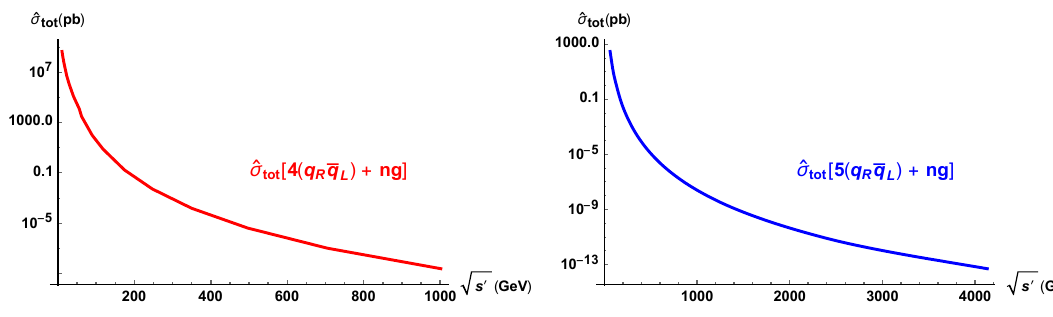
p s 0 . The plot on